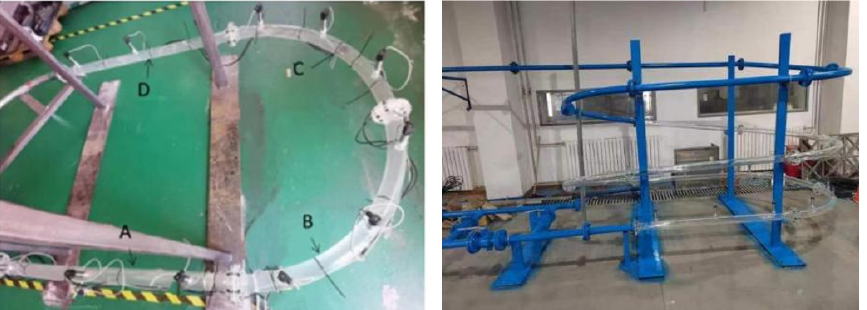
Figure 22. Test bench construction. Table 2. Piping laboratory equipment.